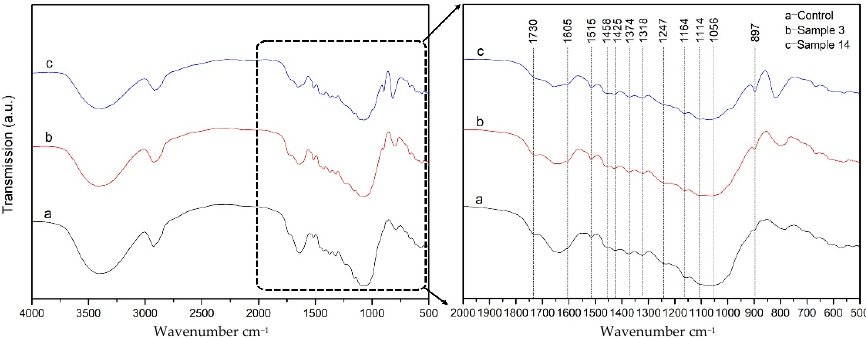
Figure 4. FT ‐ IR spectra of rice straw samples before and after LHW and LHW ‐ PTA Figure 4. FT-IR spectra of rice straw samples before and after LHW and LHW-PTA pretreatment. pretreatment.